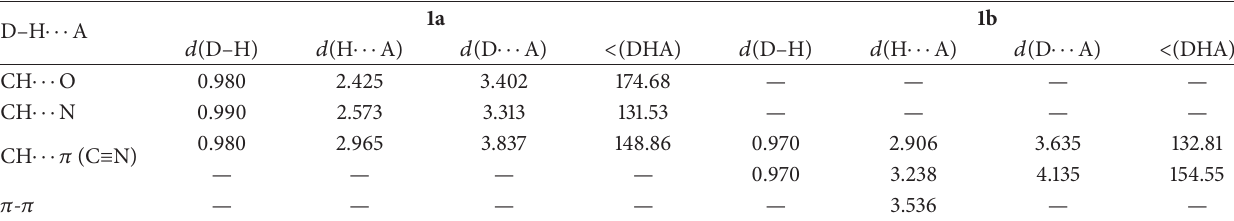
Table 3: Intermolecular hydrogen: bonding geometry (˚A and deg) for 1a and 1b